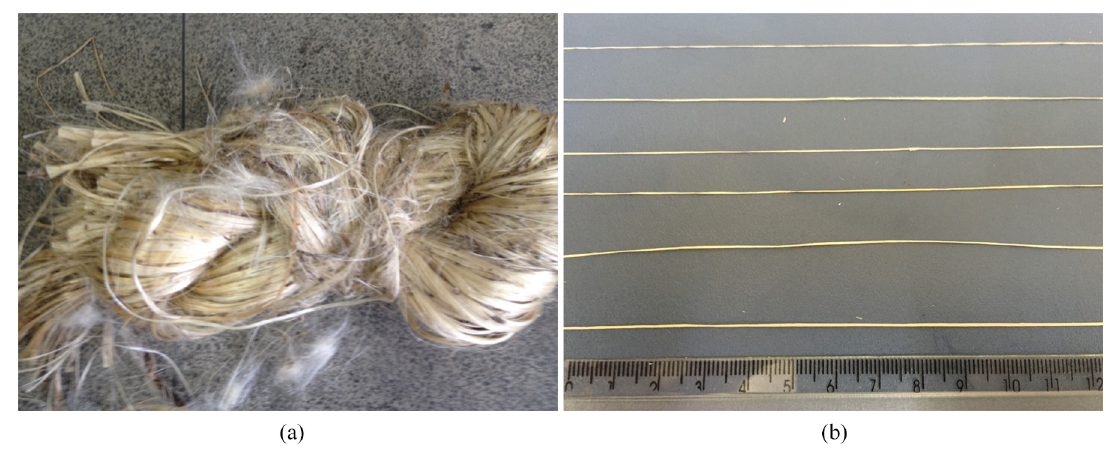
Figure 2. Bundle of malva fibers (a) and separated long and continuous fiber for composite reinforcement